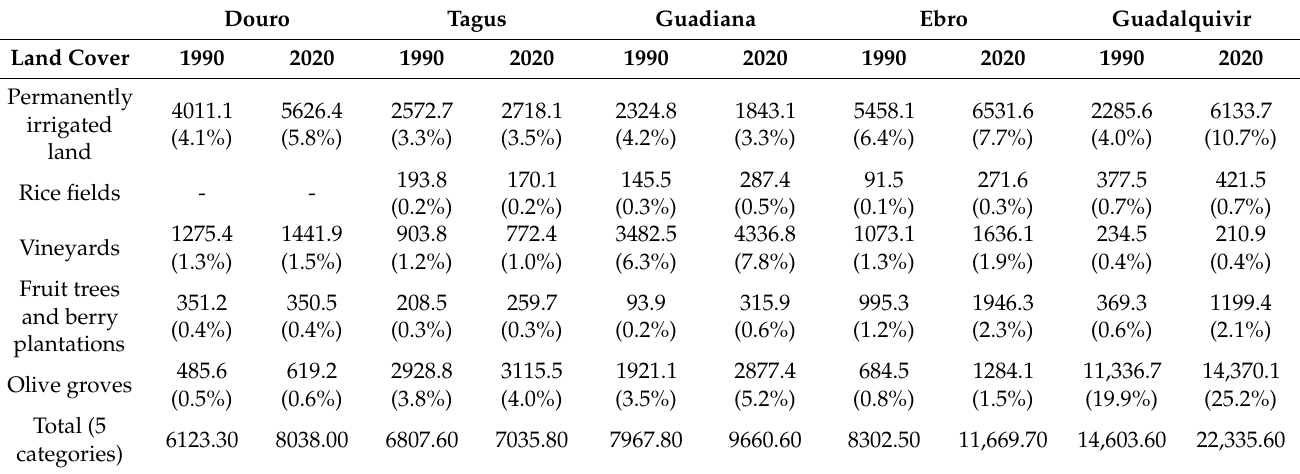
Table 1. Land cover categories area (in km 2 ) for the five main rivers in the Iberian Peninsula for the years 1990 and